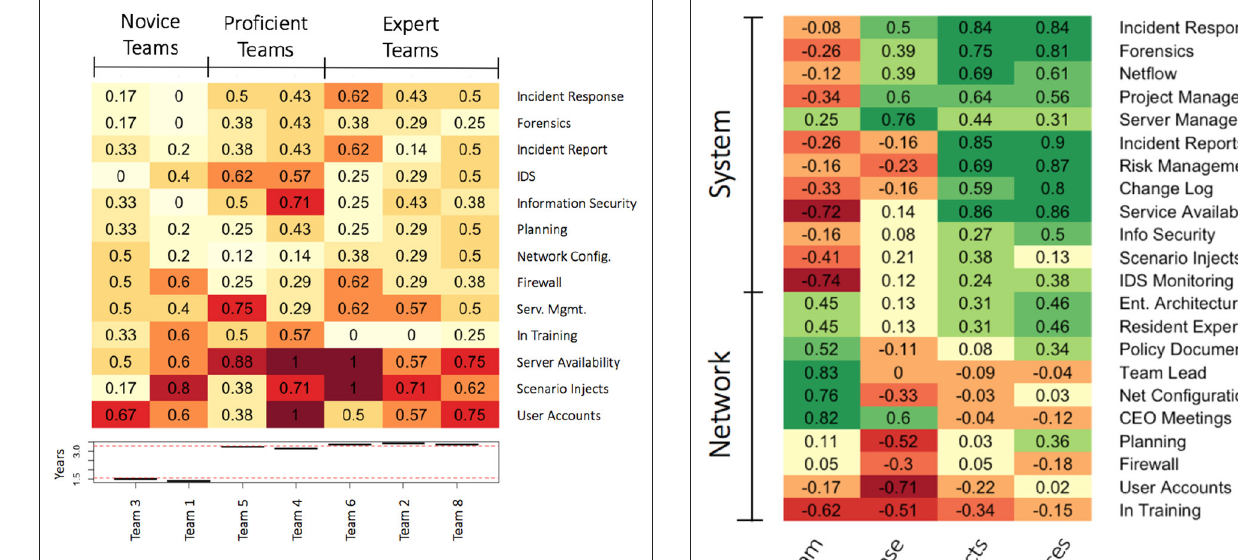
FIGURE 5 | (Top) Heatmap representation depicting the skill composition of the various cybersecurity teams with darker colors indicating the proportion of team members endorsing a particular skill or role. (Bottom) Histogram of average years experience by each team.